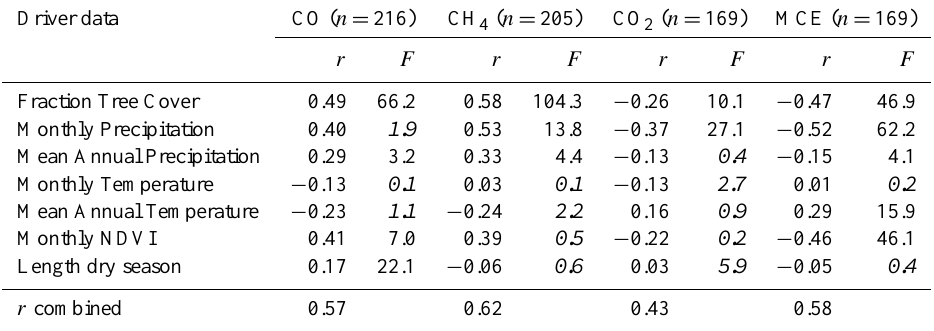
Table 1. Correlation coefficients ( r ) and F -values ( F ) for different environmental variables and CO, CH 4 , CO 2 EFs and MCE measurements. The correlation coefficients for the multivariate regression equation are also shown ( r combined). n corresponds to the number of samples used, and F -values shown in italic indicate relations that did not exceed the critical F -value for a significance level of 0.01. Driver data CO ( n = 216) CH 4 ( n = 205) CO 2 ( n = 169) MCE ( n = 169) r F r F r F r F Fraction Tree Cover 0.49 66.2 Monthly Precipitation Monthly